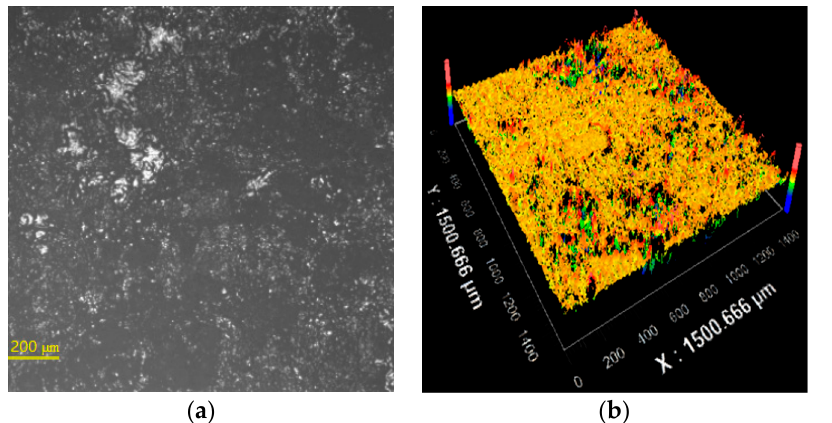
Figure 1. Flowchart of the proposed method.